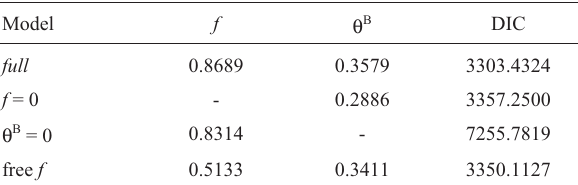
Table 4 - Bayesian analysis of population divergence for 11 local popula- tionsof Eupemphixnattereri usingtheHICKORYversion1.0programin- cluding the tested models, the estimates of f and θ B and the deviant information criterion (DIC). Model